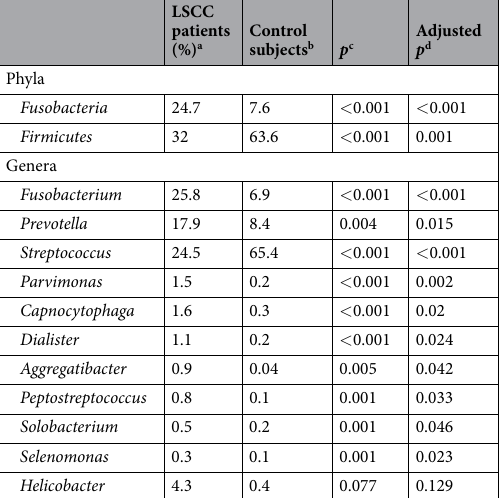
Table 2. Differences in the bacterial communities in the larynx of LSCC patients and control subjects. a LSCC patients refered to laryngeal squamous cell carcinoma patients. b The control subjects were subjects with vocal cord polyps. c The p values were tested by Student’s t-test. d The adjusted p values were adjusted by the false discovery rate